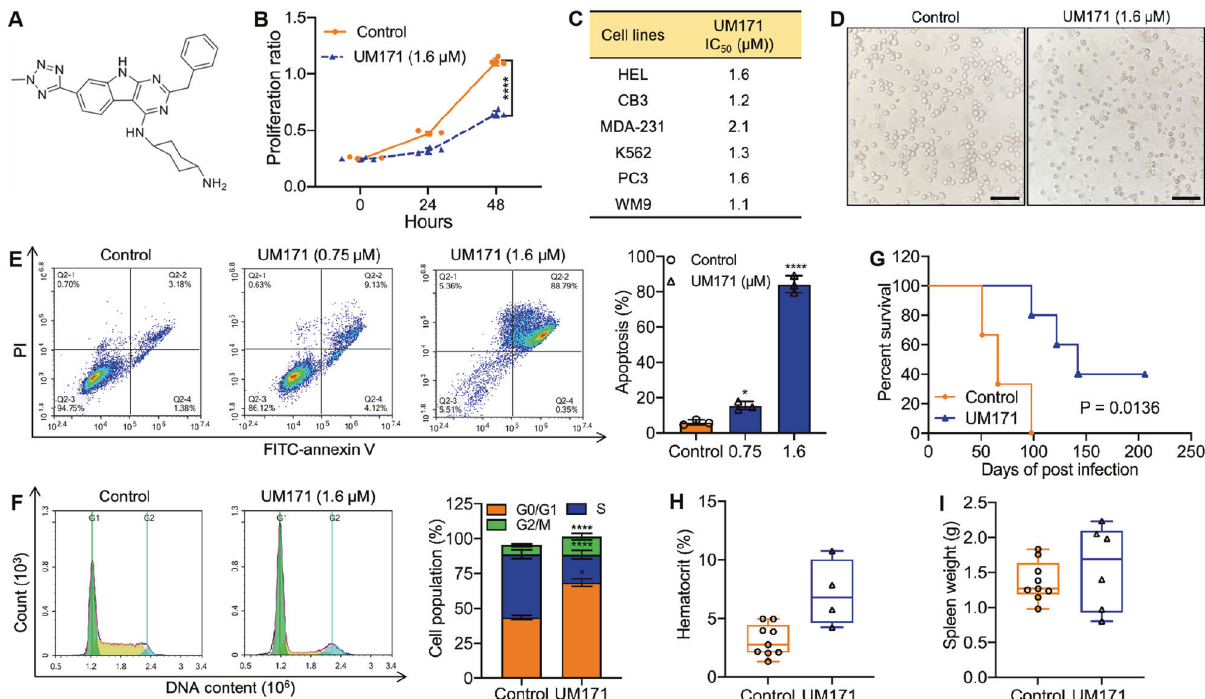
Fig. 1 Inhibition of leukemogenesis by UM171 in culture and in vivo. A Structure of UM171. B UM171 at indicated concentration inhibits proliferation of HEL cells in culture. C IC 50 analysis of UM171 for the indicated cell lines. D Macroscopic image of apoptotic cells after treatment of HEL cells with 1.6 μ M of UM171 (original magni fi cation X20, scale bars, 100 μ m). E UM171 induces apoptosis of HEL cells at the indicated concentrations. F UM171 induces G 1 /S cell cycle arrest of HEL cell at indicated concentrations. G Newborn BALB/c mice infected with F-MuLV were treated for two weeks with UM171 (3 mg/ Kg), 5 weeks postviral infection, and plotted after all mice succumbed to leukemia. H , I UM171 treated mice with their hematocrit values ( H ) and tumor volume ( I ) at the time of